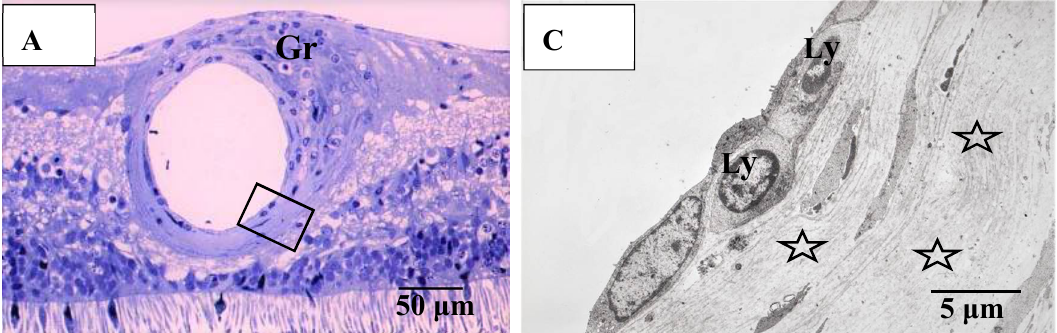
Figure 11. Light microscopy photographs of the peripheral area of the retina and choroid in the right eye of Autopsy Case 2, a 78-year-old female with a max IOP of 22 mmHg (methylmethacrylate embedding, toluidine blue stain). The retina and choroid became very thin ( small star ) at the center of chorioretinal atrophy, which was surrounded by abnormally thick fibrotic tissue in the choroid ( large stars ).